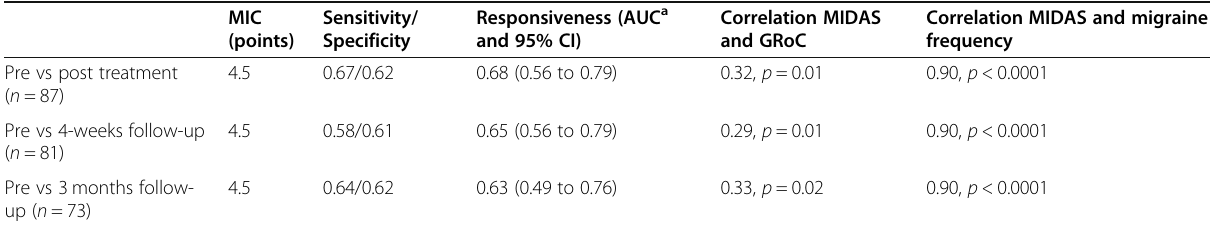
Table 2 Minimal important change (MIC), sensitivity & specificity, responsiveness and Pearson ’ s correlation between migraine disability assessment scale ( MIDAS) change scores, migraine frequency change and global rating scale of change (GRoC) after non- pharmacological